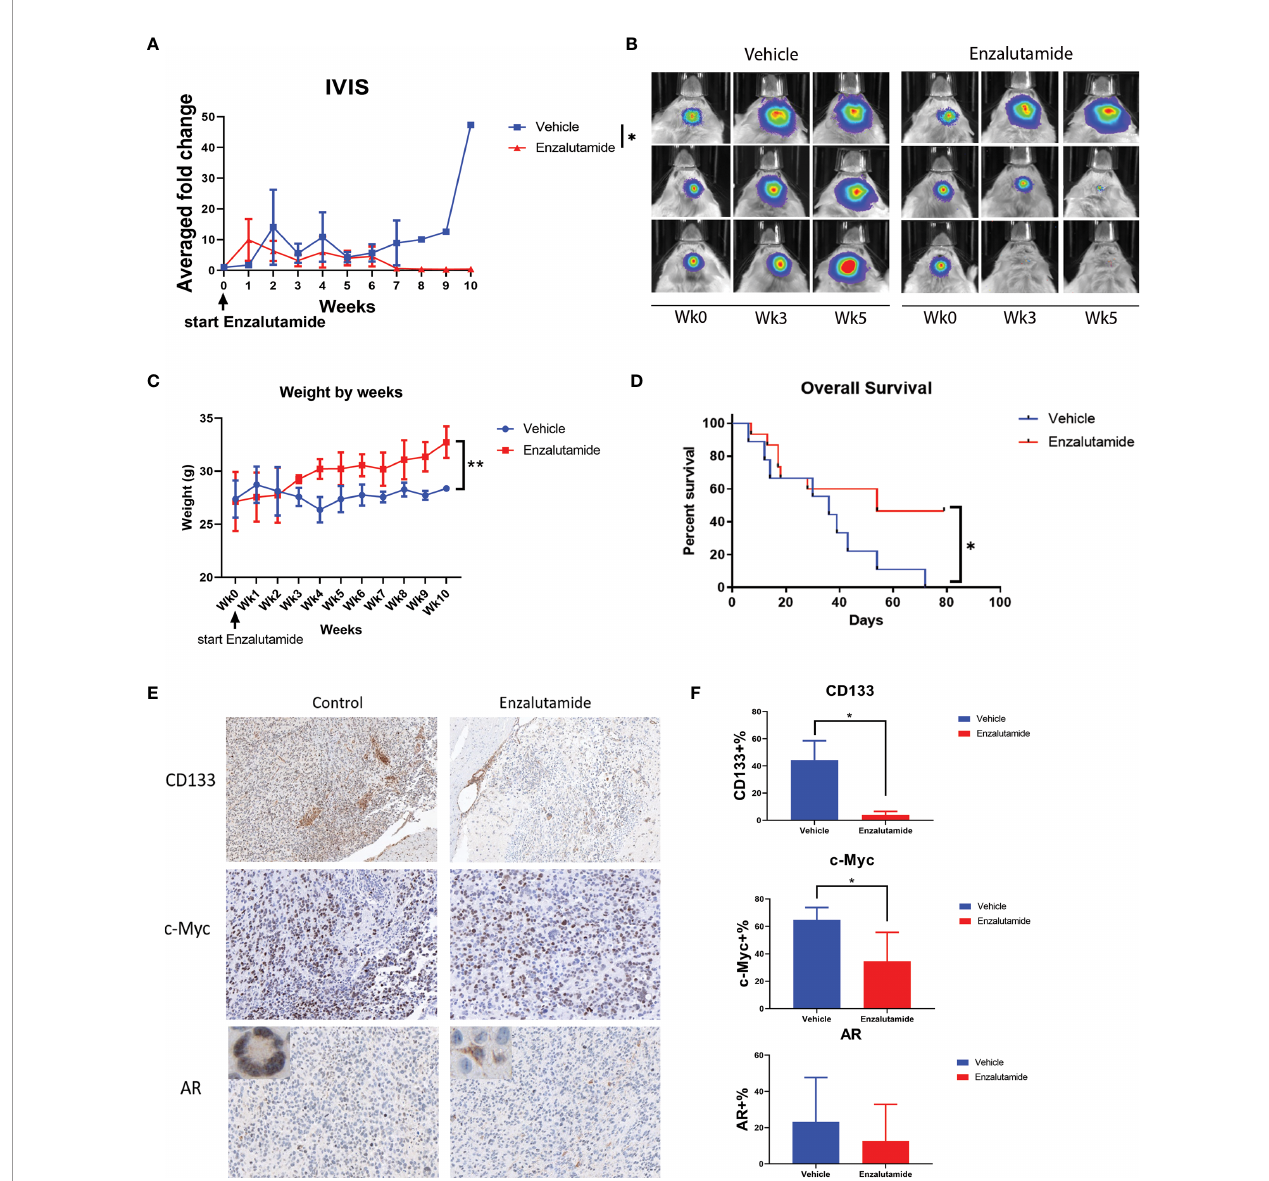
FIGURE 6 | Enzalutamide suppresses CSC marker gene expression, GBM tumor growth in vivo and prolongs overall survival in treated mice with MGPP3 cells implanted in brain. (A) Fold changes of the bioluminescent signals of the tumors in brain after the treatment of vehicle only or enzalutamide (20 mg/kg, three times per week, IP). (B) Representative IVIS images of the tumor growth in mouse brain after vehicle only or enzalutamide treatment. Wk 0, 3 and 5: IVIS imaging taken prior to (week 0), 3 and 5 weeks after initiating of drug injection. Mann – Whitney U tests were performed in both (A, B) to compare between groups. (C) Weight changes of the mice after the treatment. (D) Overall survival was signi fi cantly improved in mice treated with enzalutamide comparing with vehicle only. (E) Representative images of the mouse brain tissue after IHC staining for CD133 (100×), c-Myc (200×), and AR (200×). Corner image (left upper corner of the left panel): high magni fi cation image showing tumor cells with positive AR staining with nuclear localization without enzalutamide treatment. Corner image (left upper corner of the right panel): high magni fi cation image showing tumor cells with positive AR staining but more cytosol distribution after enzalutamide treatment. (F) Quanti fi cations of positive cells in the brain tumors from IHC staining after vehicle only or enzalutamide treatment. Two-tailed student t tests were performed for statistical comparisons. *p < 0.05; **p <